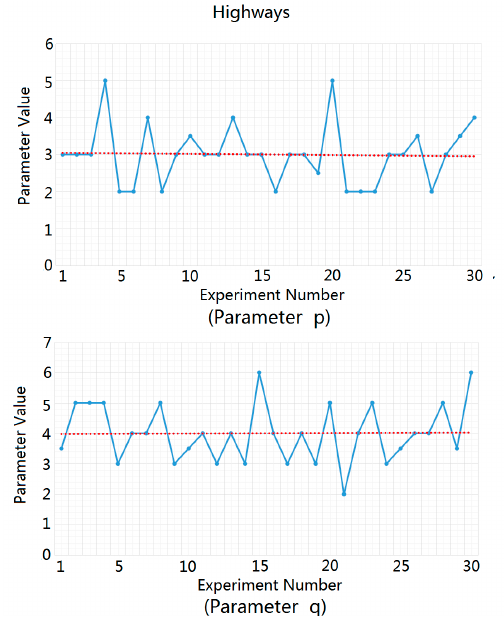
Figure 7. Solution process of parameters 𝑝 and 𝑞 for highways.